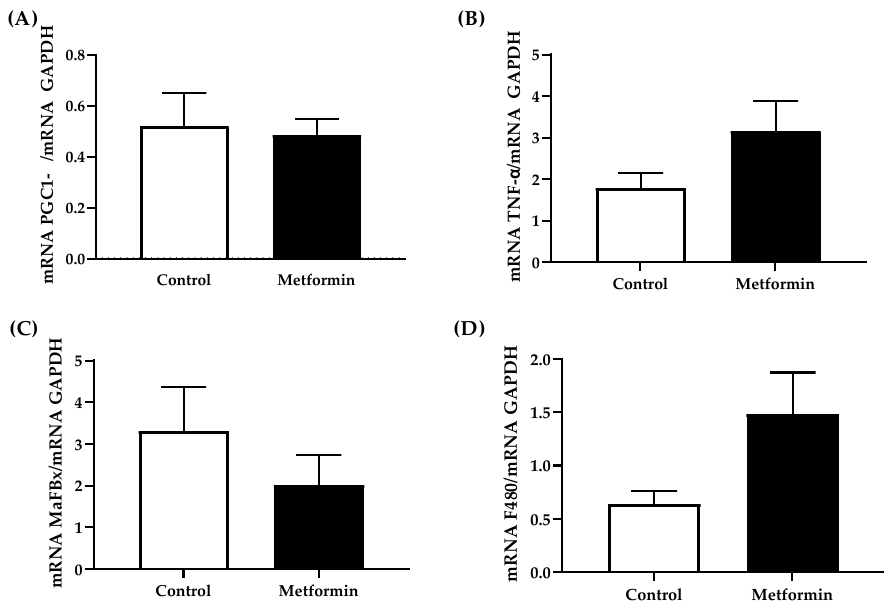
Figure 7. Gene expression in gastrocnemius muscle from C57BL/6J mice with orthotopically im- planted LL/2 non-small lung cancer cells. ( A ) mRNA Peroxisome proliferator-activated receptor- gamma coactivator-1alpha (PGC1- α )/GAPDH; ( B ) mRNA tumor necrosis factor-alpha (TNF- α )/GAPDH; ( C ) mRNA muscle atrophy F-box (MAFbx)/GAPDH; ( D ) mRNA F480/GAPDH. Gas- trocnemius mRNA expression from C57BL/6J mice with NSCLC concomitant with or without metformin (250 mg/kg) treatment. Data were analyzed using an unpaired t -test. Sample size: Control, n = 7; metformin, n = 7. Data shown as mean ± SEM.